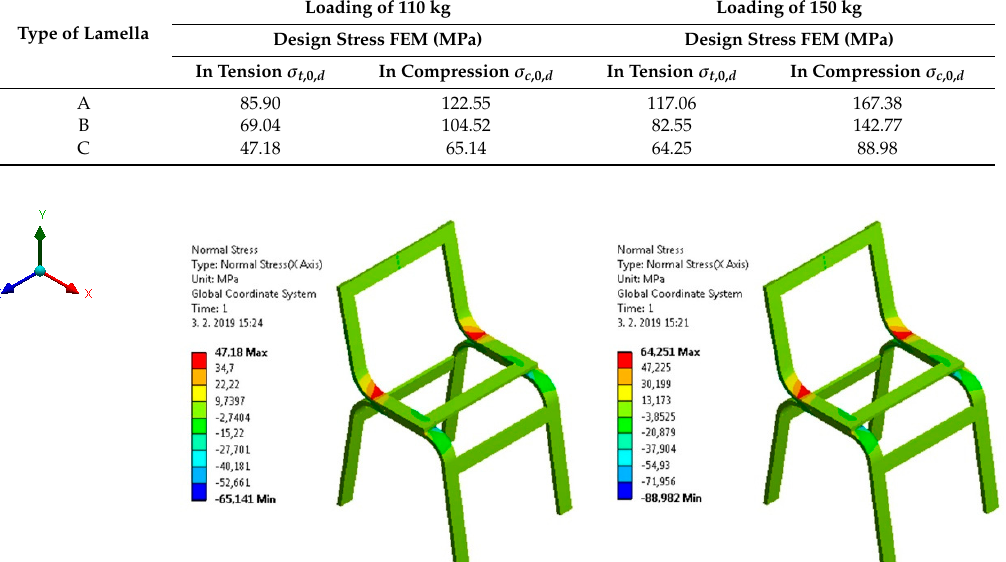
Table 4. Maximum values of normal stress for the pitch seat-to-back angle of 103 ◦ .